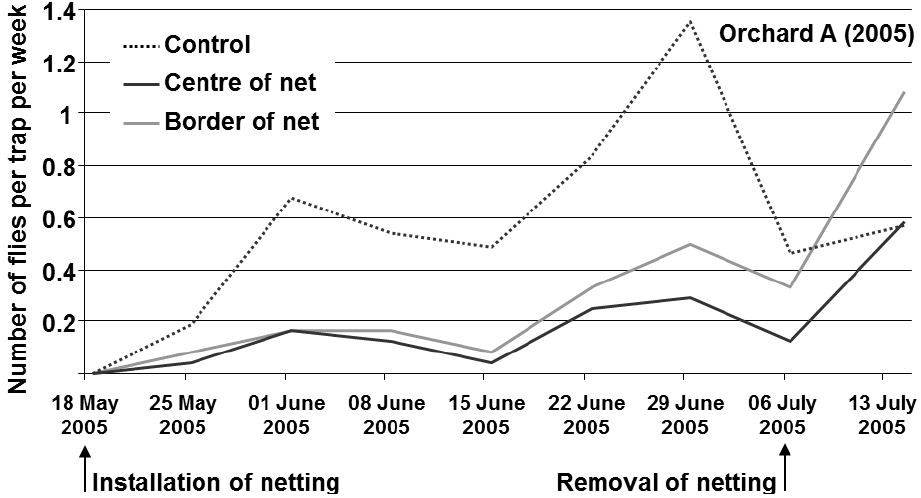
Figure 1. Flight activity of R. cerasi in orchard A in 2005.